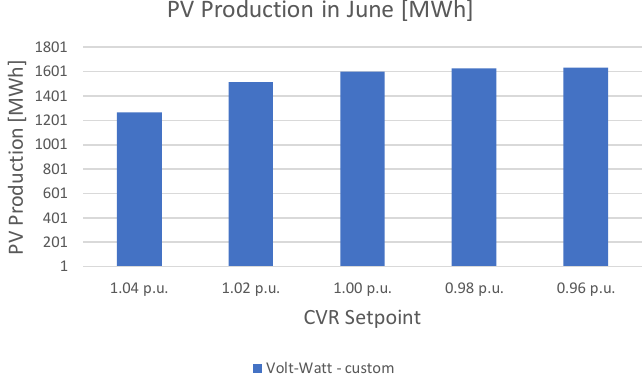
Figure 14. Total PV produced in June for various CVR voltage setpoints.